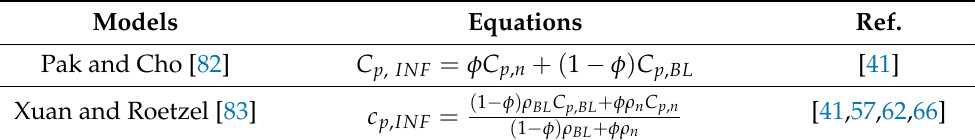
Table 7. Theoretical models of the heat capacity of ILs-based nanofluids.